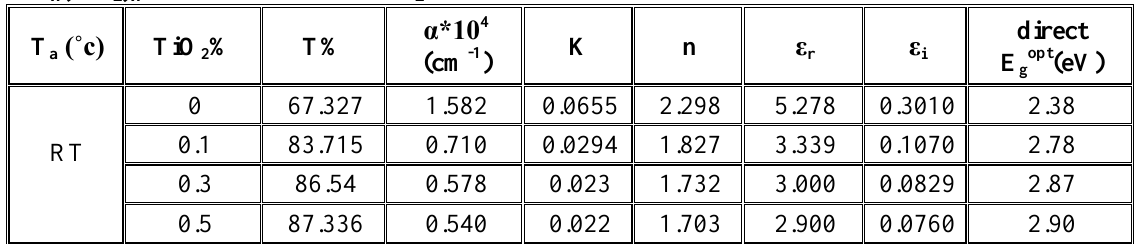
Table 2: illustrate the values of Egopt and optical constants at λc=520 nm for (V (TiO ) films with different TiO x 2 x